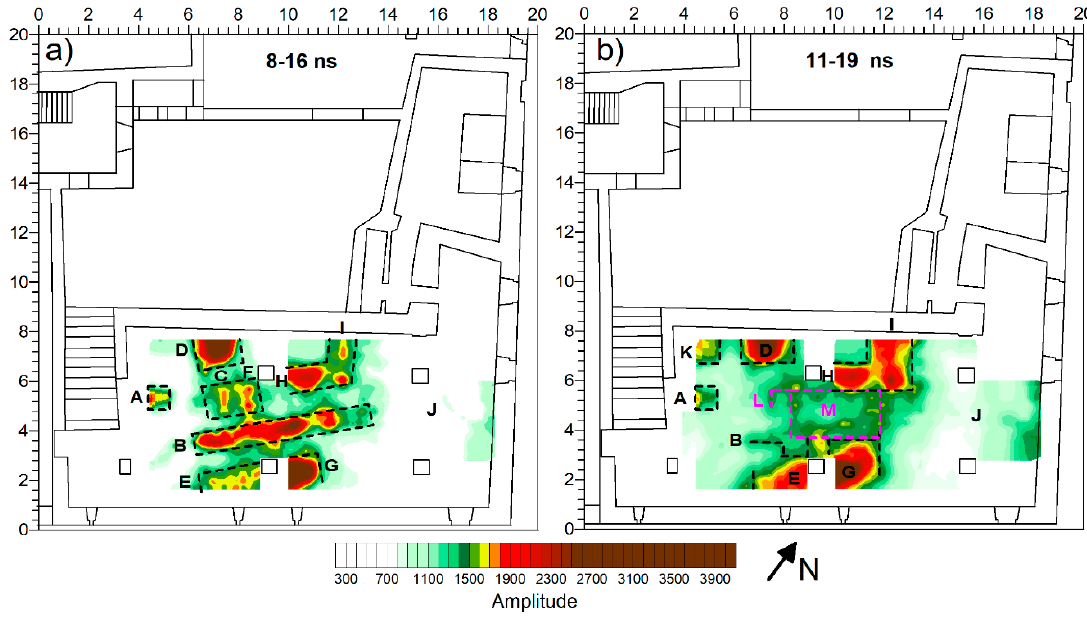
Figure 8. Time slices relative to the time windows 8–16 ns ( a ) and 11–19 ns ( b ) with an interpretation of anomalies. Distances in meters.